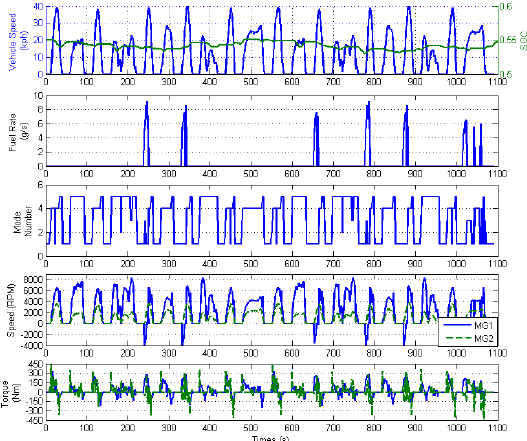
Figure 13. State and control trajectories of the simulated optimal powertrain design under the Manhattan cycle by near ‐ optimal control strategy PEARS+.